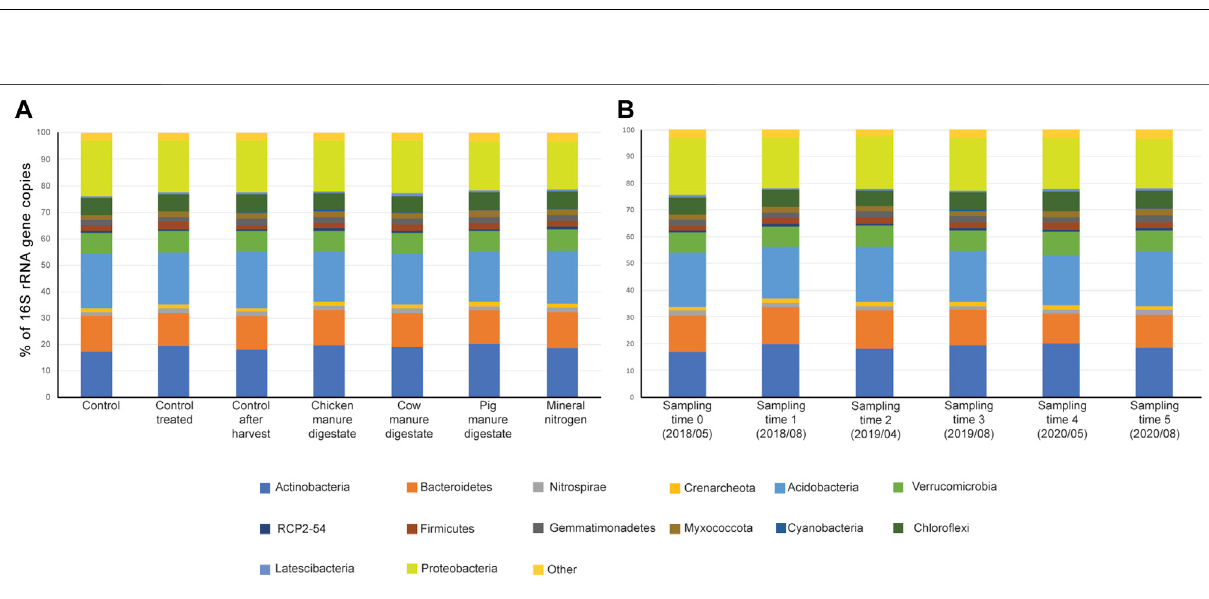
Frontiers in Environmental Science |